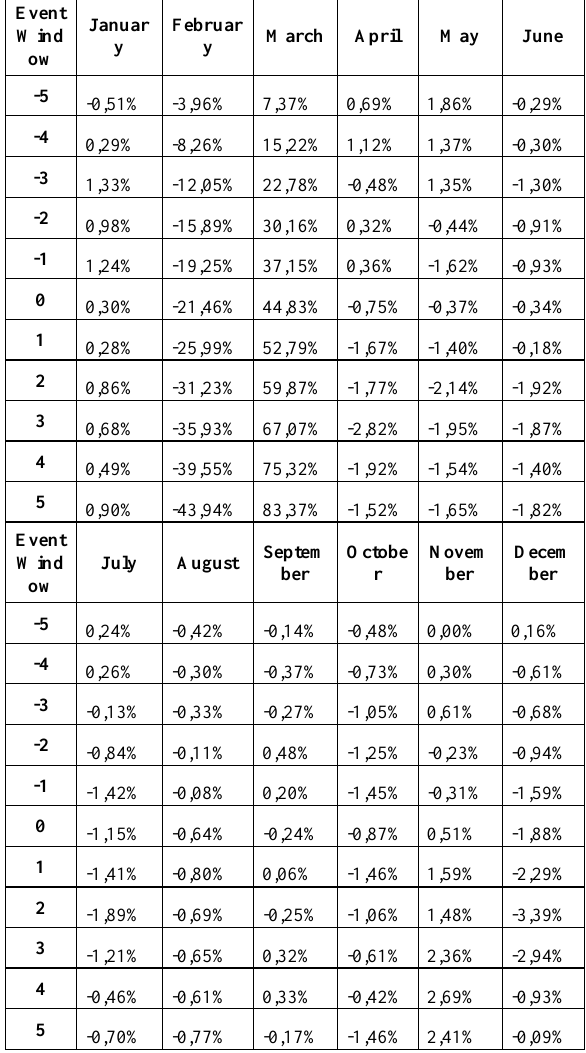
Figure 2 represents the graphs of Cumulative Abnormal Returns (CAR) in 2012. Cumulative abnormal returns generally do not continuously decrease or increase before or after the event days except in February and in March. CAR values steadily decrease before and after the event day only in February. On the other hand, CAR values steadily increase before and after the event day only in March. The CAR values of the other months show a fluctuating